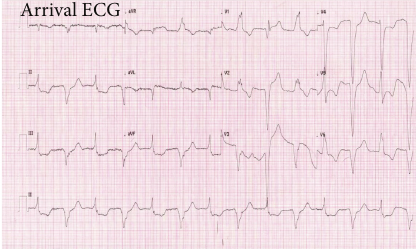
Figure 1: ECG recorded during the patient’s arrival in emergency department showing atrial fibrillation with alternating right and left bundle branch block pattern with ST-T segment changes.